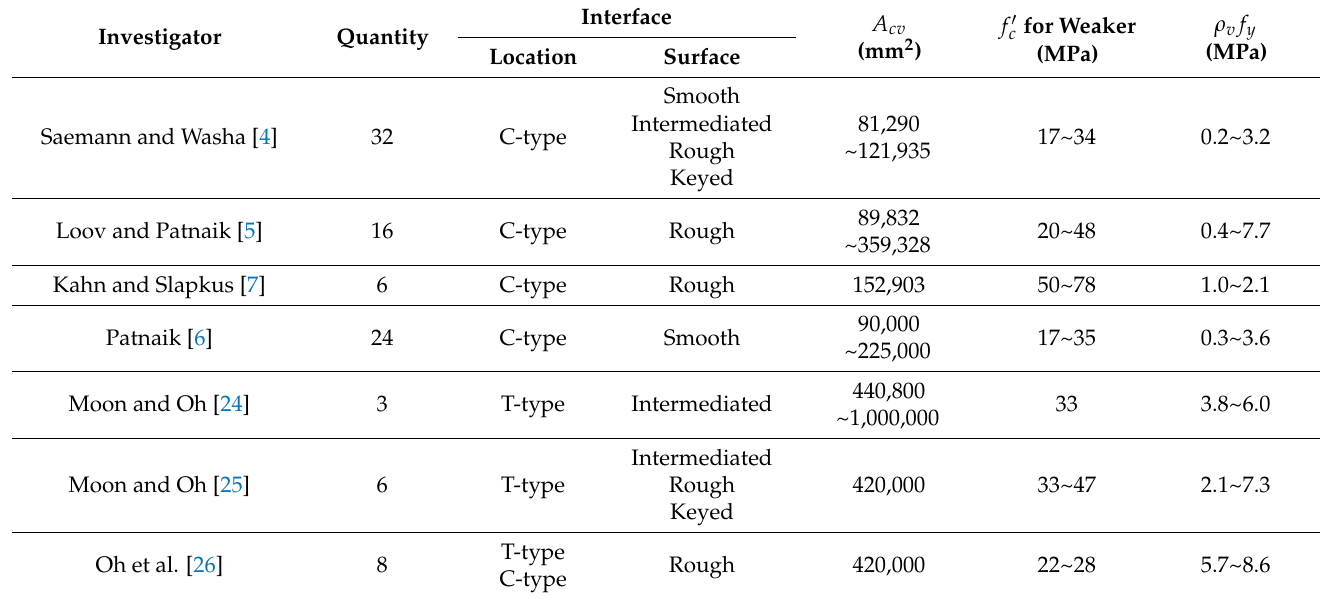
Table 4. List from experimental database by beam tests.